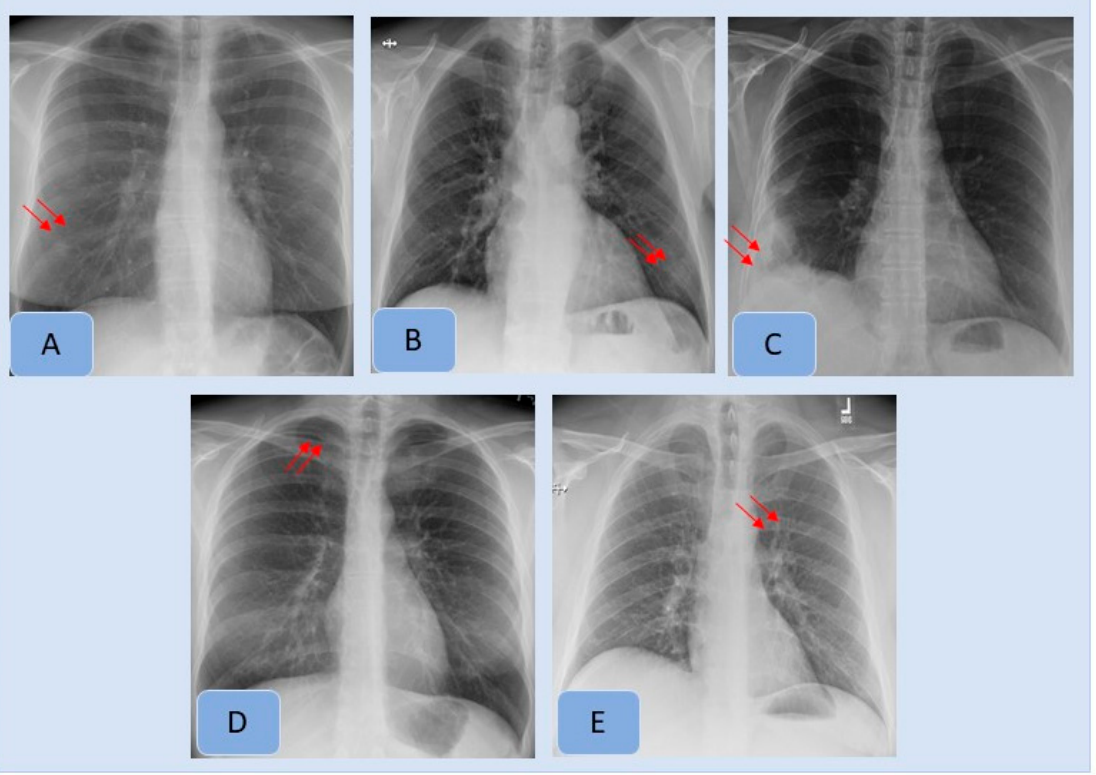
Figure 3. Examples of clinically important missed findings on CXRs included in our study. These included pulmonary nodule ( A ), consolidation ( B ), pleural effusion ( C ), pneumothorax ( D ) and hilar prominence ( E